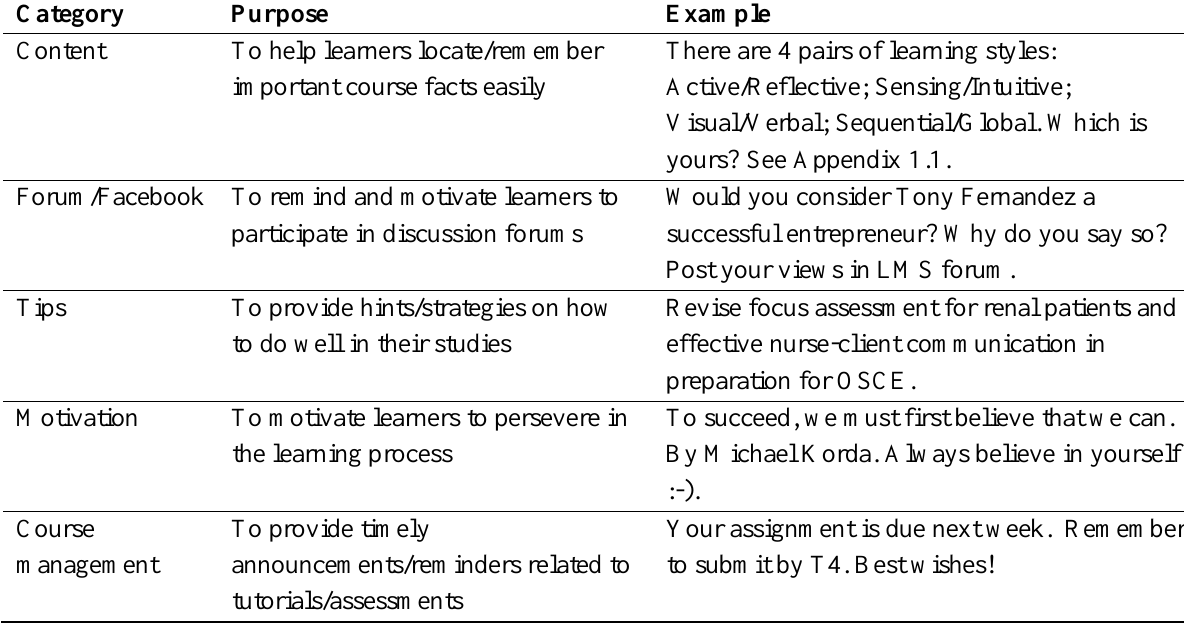
Table 1 SMS Categories, Purpose, and Examples Category